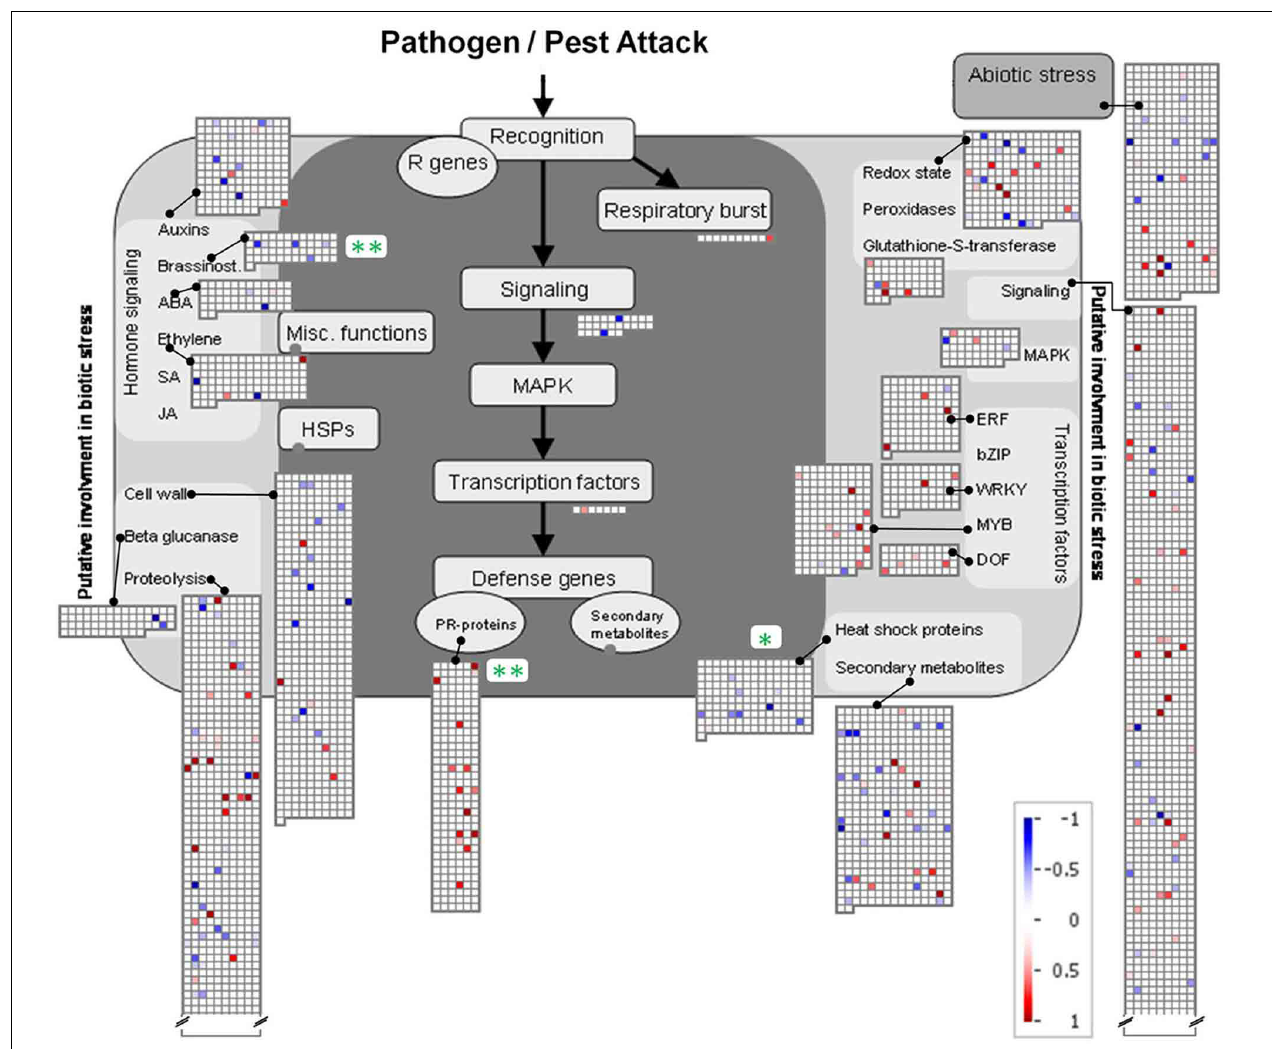
FIGURE 6 | MapMan depiction of gene regulations in functional categories associated with ´Cbiotic stress’ in A. thaliana roots exposed to H. pilosella . Asterisks denote significantly regulated functional (sub-)categories following Wilcoxon Rank Sum statistics (Benjamini Hochberg